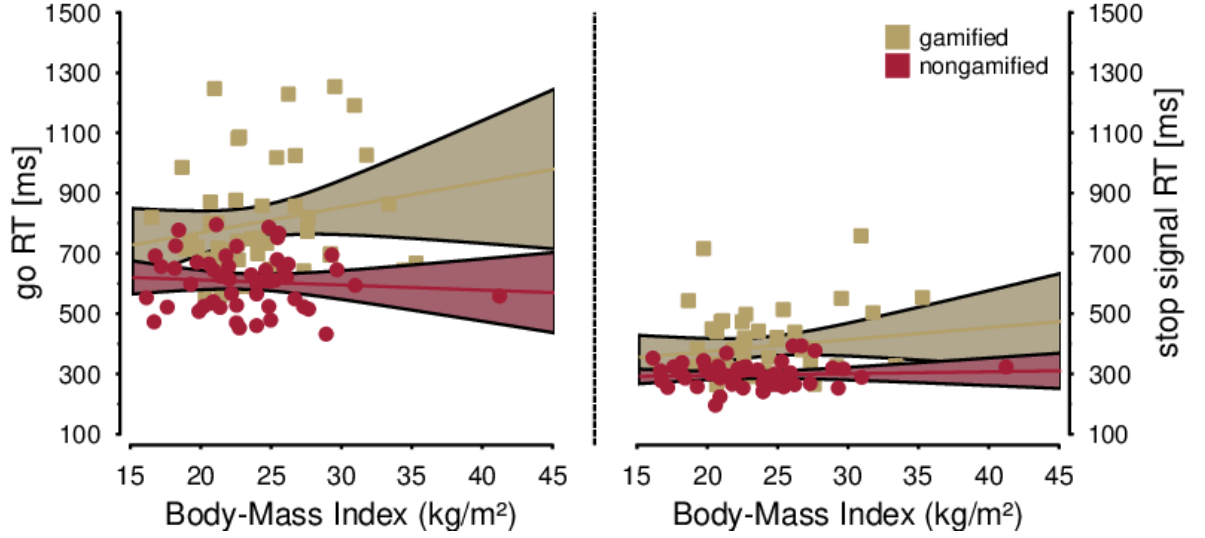
Figure 5. Scatter plots of BMI as a predictor for go reaction time (left) and stop-signal reaction time (right). The gamified versus nongamified condition qualified the association with mean go reaction time but not with stop-signal reaction time. RT: reaction